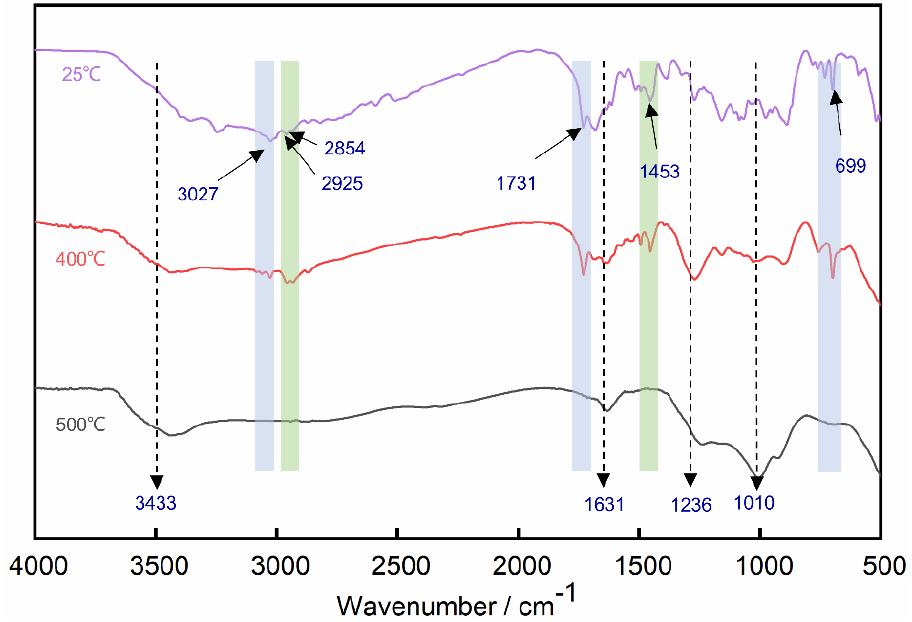
Figure 6. FTIR spectra of MPP/PAPP-IC at different temperatures. Table 5. The assignments of the characteristic vibration peaks of MPP/PAPP - IC [19,32].